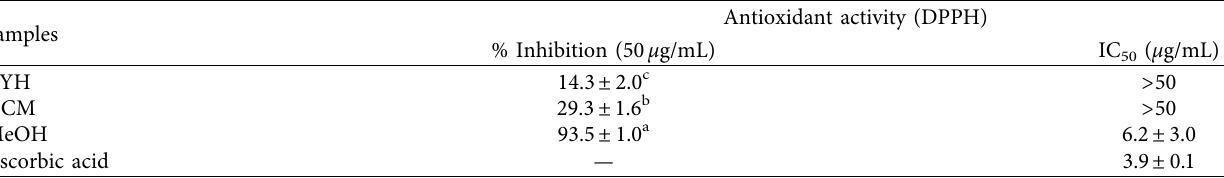
Table 2: Antioxidant activity of the areal part of R. crispus extracts.